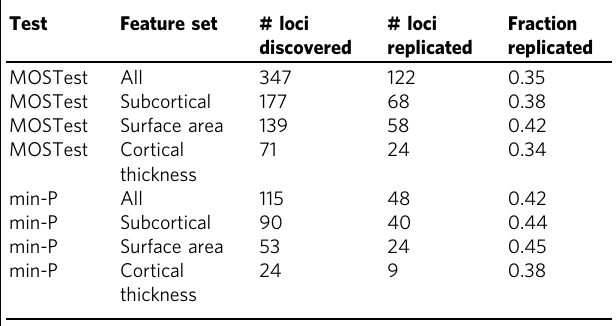
Table 1 Equal replication rates of genome-wide signi fi cant loci by MOSTest and min-P.